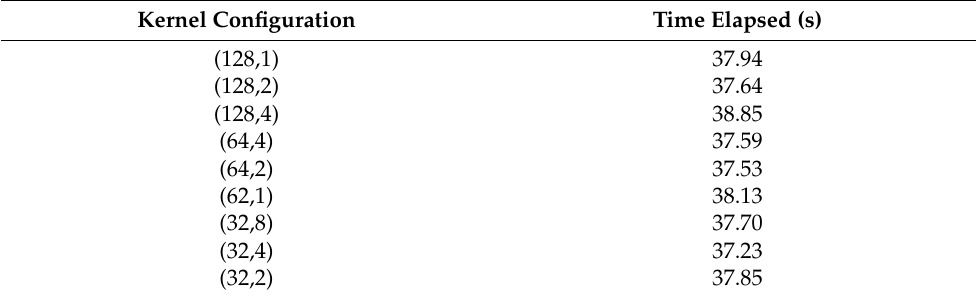
Table 3. Time elapsed with different kernel configuration.